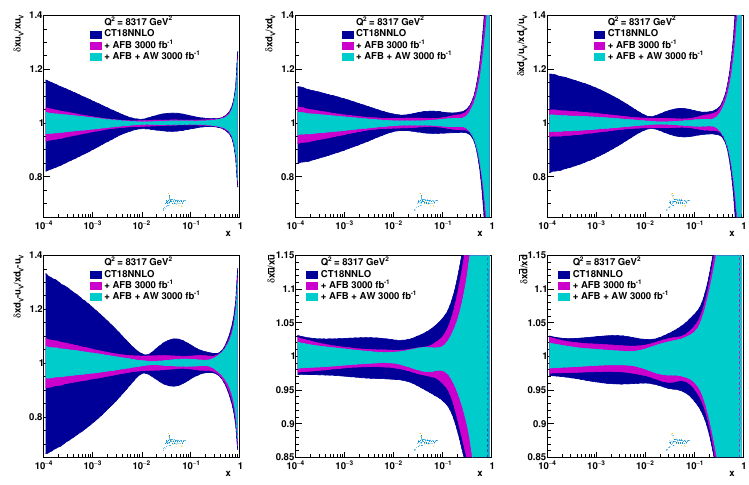
Figure 2: Same as in Fig. 1 but for an integrated luminosity of 3000 fb − 1 .